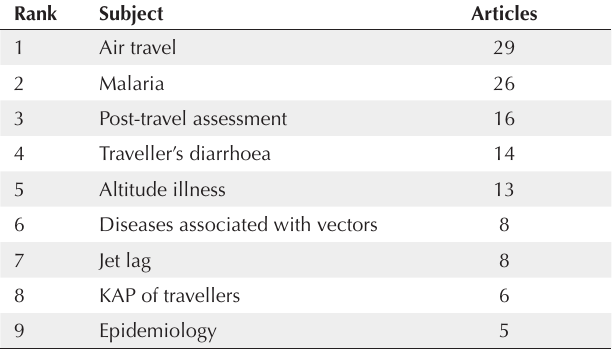
Table 7. Thematic Analysis of Most Frequently Cited